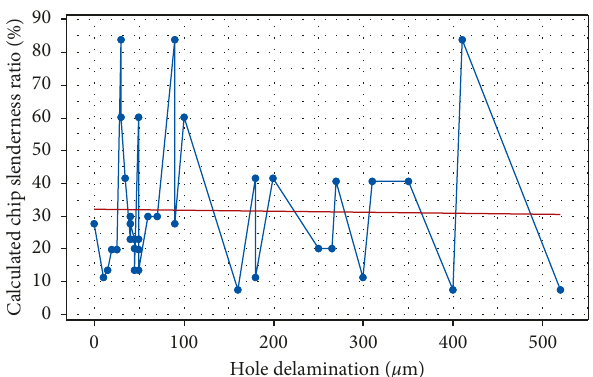
Figure 7: Effect of the calculated chip slenderness ratios on the drilled hole